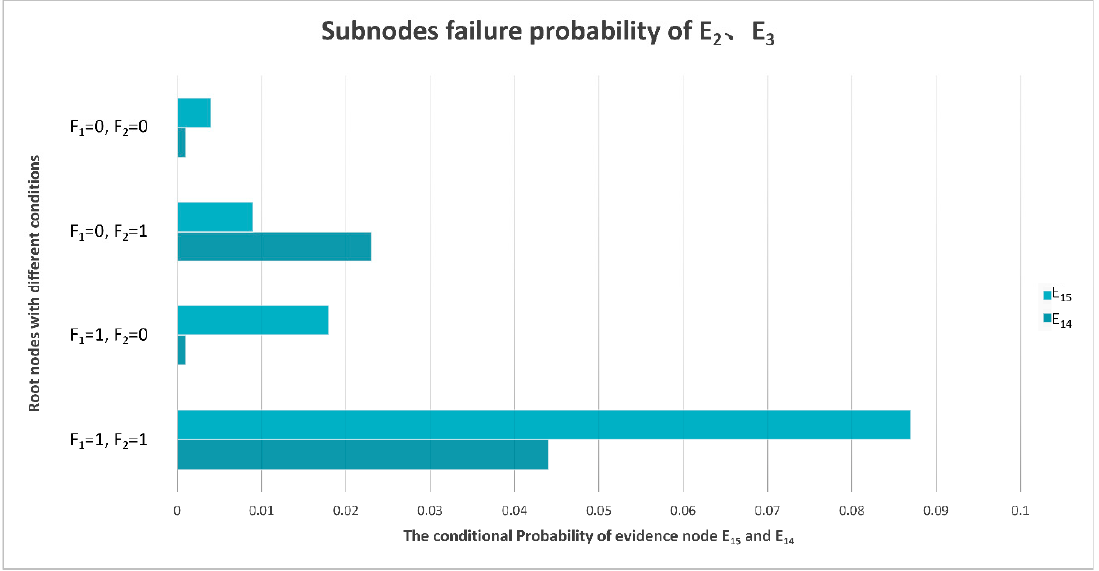
Figure 12. Conditional probability distribution diagram of sub-nodes of E 2 and E 3 .